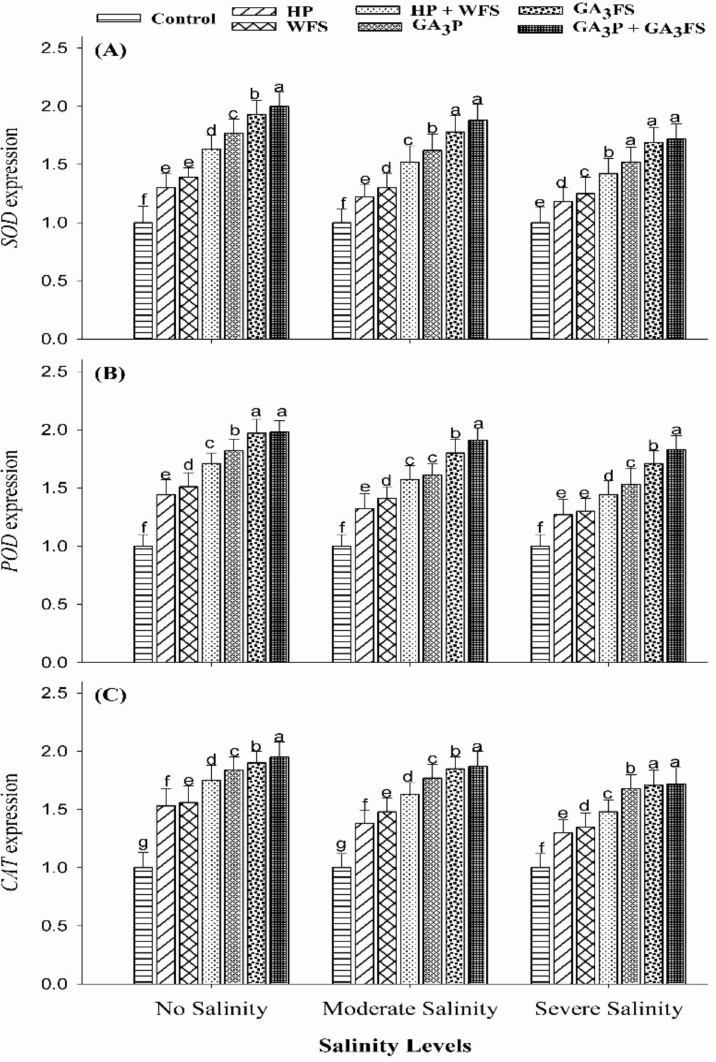
Figure 6. Expression level of SOD gene ( A ), POD gene ( B ) and CAT gene ( C ) in maize leaves as affected by different treatments of gibberellic acid under no salinity (control), moderate salinity (6 dS m − 1 ), and severe salinity (12 dS m − 1 ). Values are means ± SD (n = 3). Hydropriming (HP); water foliar spray (WFS); hydropriming and water foliar spray (HP + WFS); seed priming with GA 3 (GA 3 P); foliar spray with GA 3 (GA 3 FS); seed priming and foliar spray of GA 3 (GA 3 P + GA 3 FS). Bars with the same letters do not differ significantly at p ≤